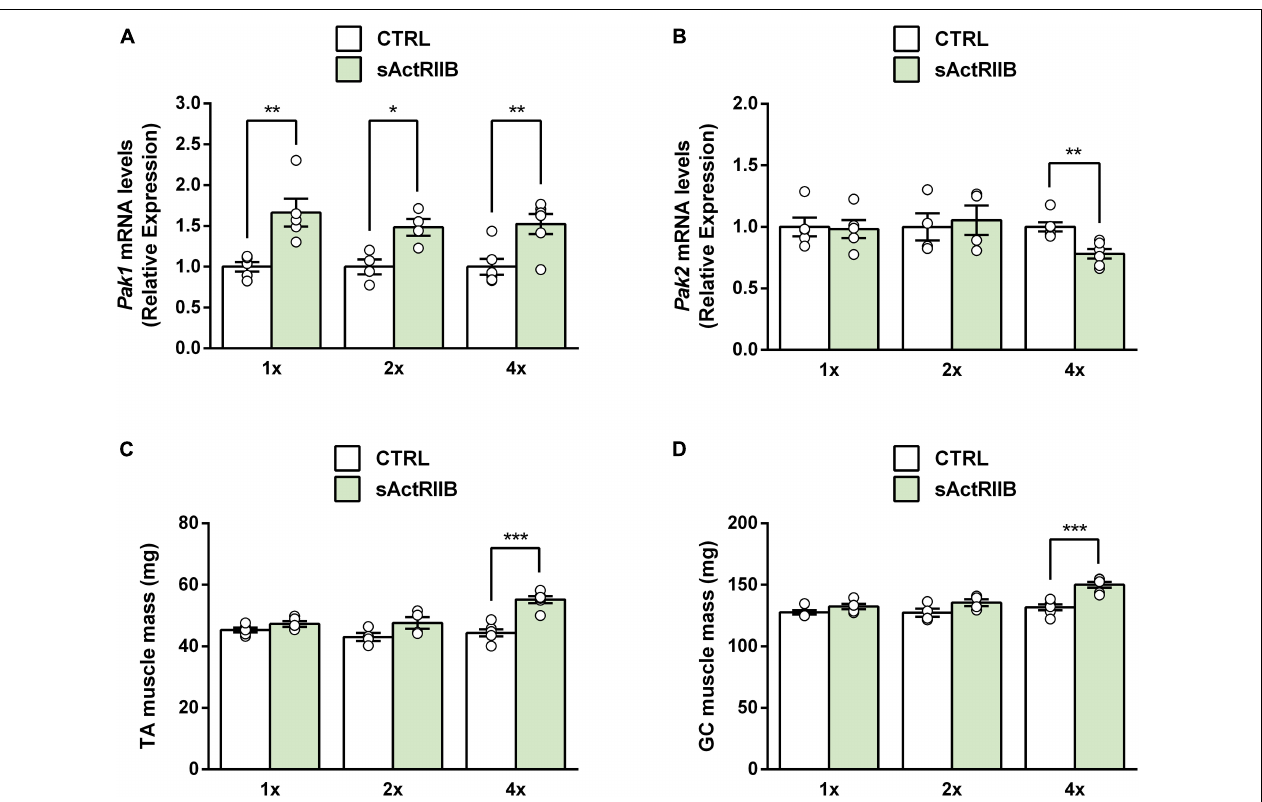
FIGURE 4 | Muscle Pak1 and Pak2 mRNA levels in response to skeletal muscle hypertrophy induced by MSTN inhibition. (A) TA muscle Pak1 and (B) Pak2 mRNA levels, (C) TA and (D) GC muscle weight after one, 2 or 4 injections of sActRIIB (green columns) or PBS (white columns) in WT mice ( n = 4–6/group). Results are expressed as means ± SEM. Statistical analysis was performed using unpaired t -test to compare results from sActRIIB-treated and PBS-treated mice (* P < 0.05; ** P < 0.01, and *** P < 0.001 vs.